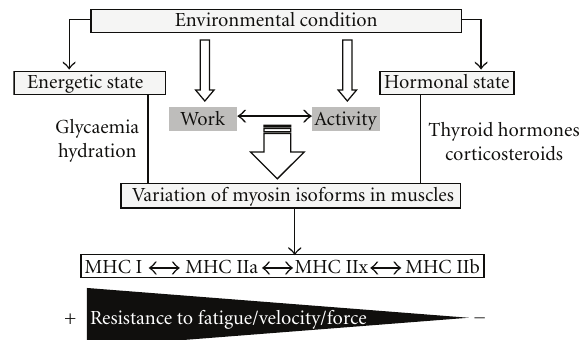
Figure 1: Diagram presenting the impact of environmental con- dition on myosin heavy chain (MHC) expression in adult skeletal muscles (I: slow; IIa: fast; IIx: fast; IIb: fast type fibres).